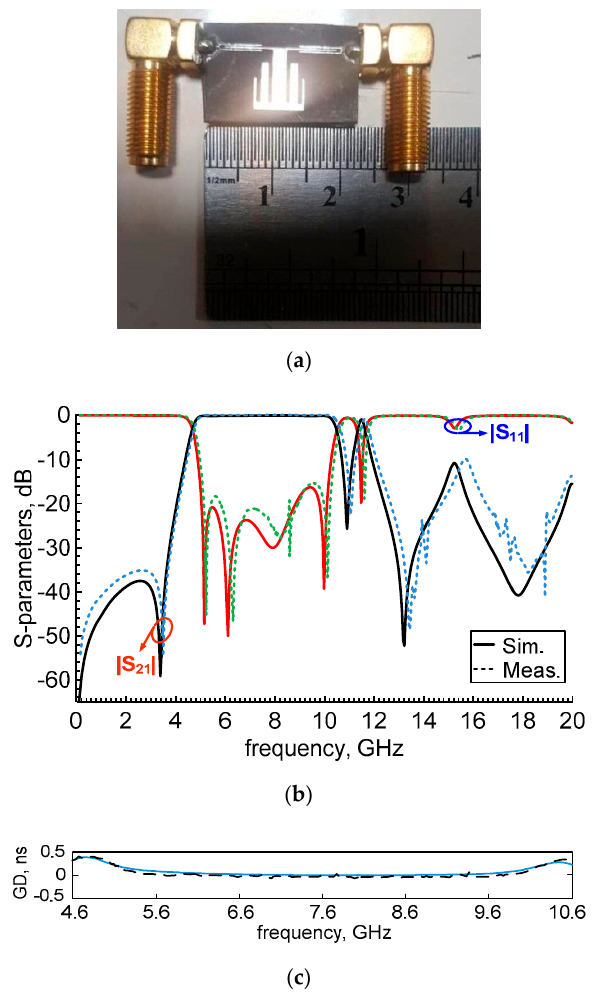
Figure 10. Simulation and experimental results: ( a ) A photo of the fabricated prototype, ( b ) S- Figure10. Simulationandexperimentalresults: ( a )Aphotoofthefabricatedprototype, ( b )S-parameters, parameters, ( c ) group delay of the wide passband. ( c ) group delay of the wide Table 1. Specifications of cited papers and proposed one.